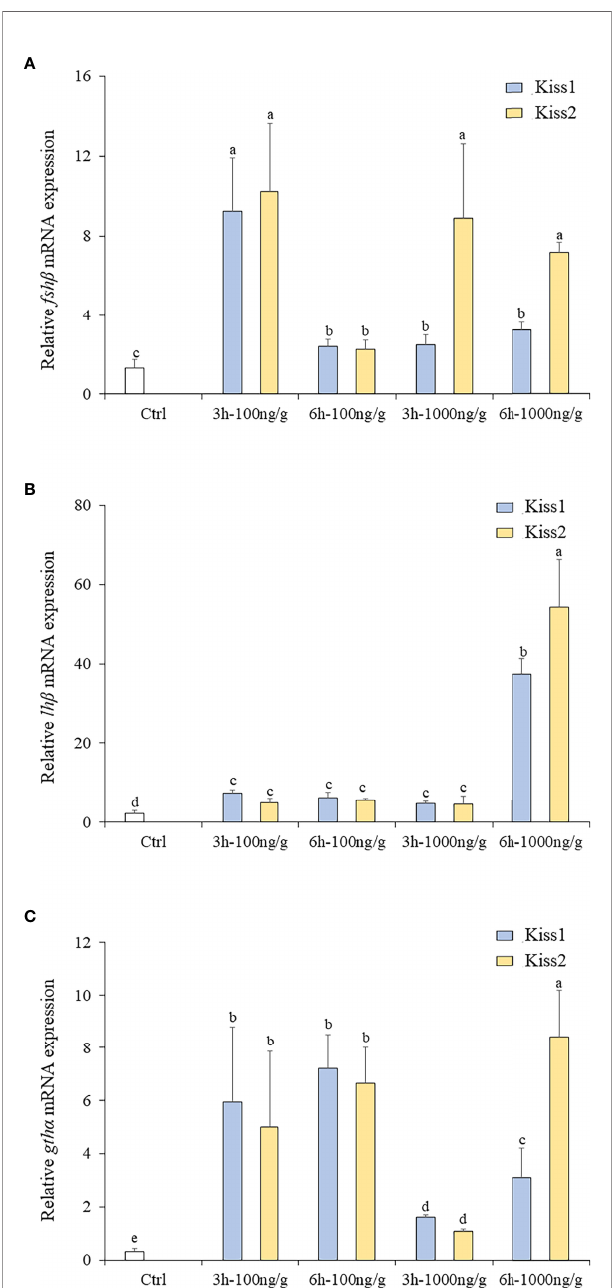
FIGURE 10 | Expression pro fi les of fhs b (A) , lh b (B) and gth a (C) in the pituitary of turbot by administration of Kiss1-10 and Kiss2-10 at 3 and 6 h post-injection. Error bars are presented as the mean ± SEM. Different letters above bars represent statistical signi fi cance ( p < 0.05